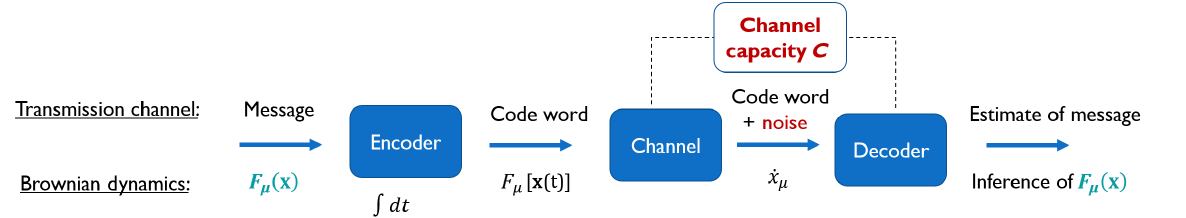
FIG. 2. The dynamics of an overdamped system can be seen as a noisy data-transmission channel encoding information about the force field, with a rate bounded by the channel capacity C as defined in Eq. (2). Note that this definition does not include the information loss stemming from the measurement device. This analogy is further discussed in the Appendix